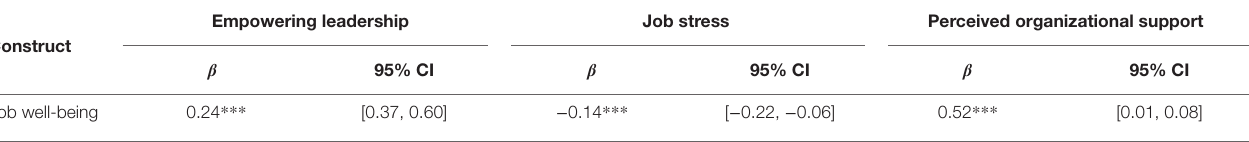
TABLE 3 | Indirect effect